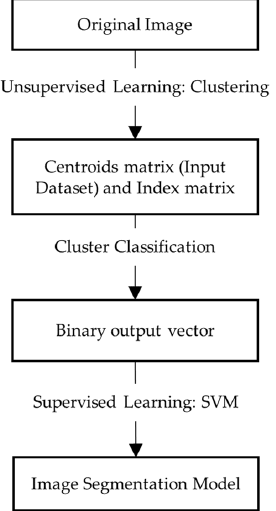
Figure 1. Support vector machine (SVM) method diagram.